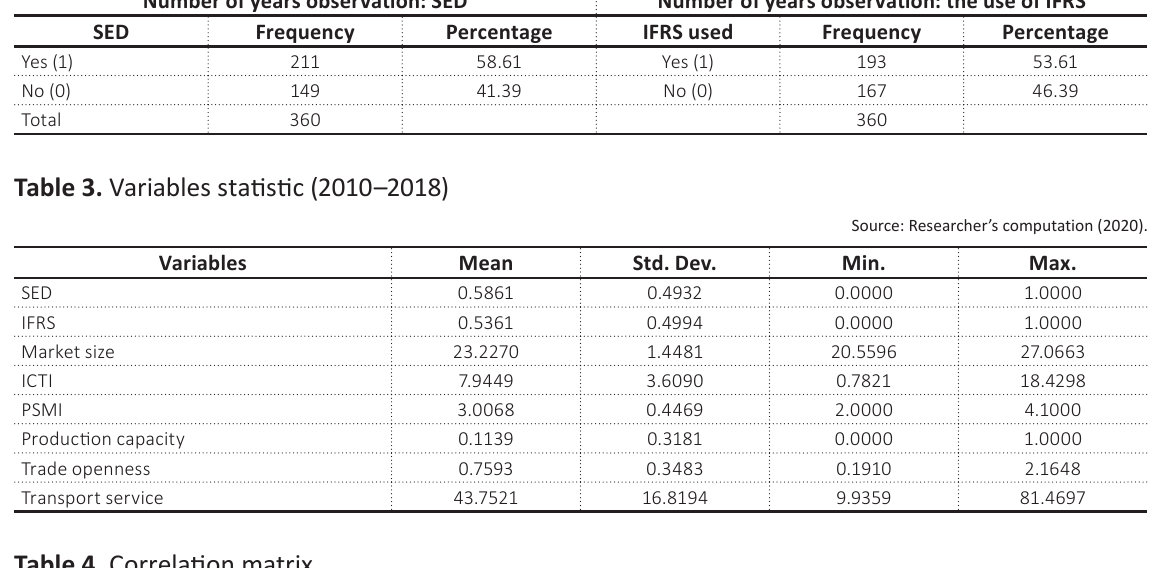
Table 4. Correlation